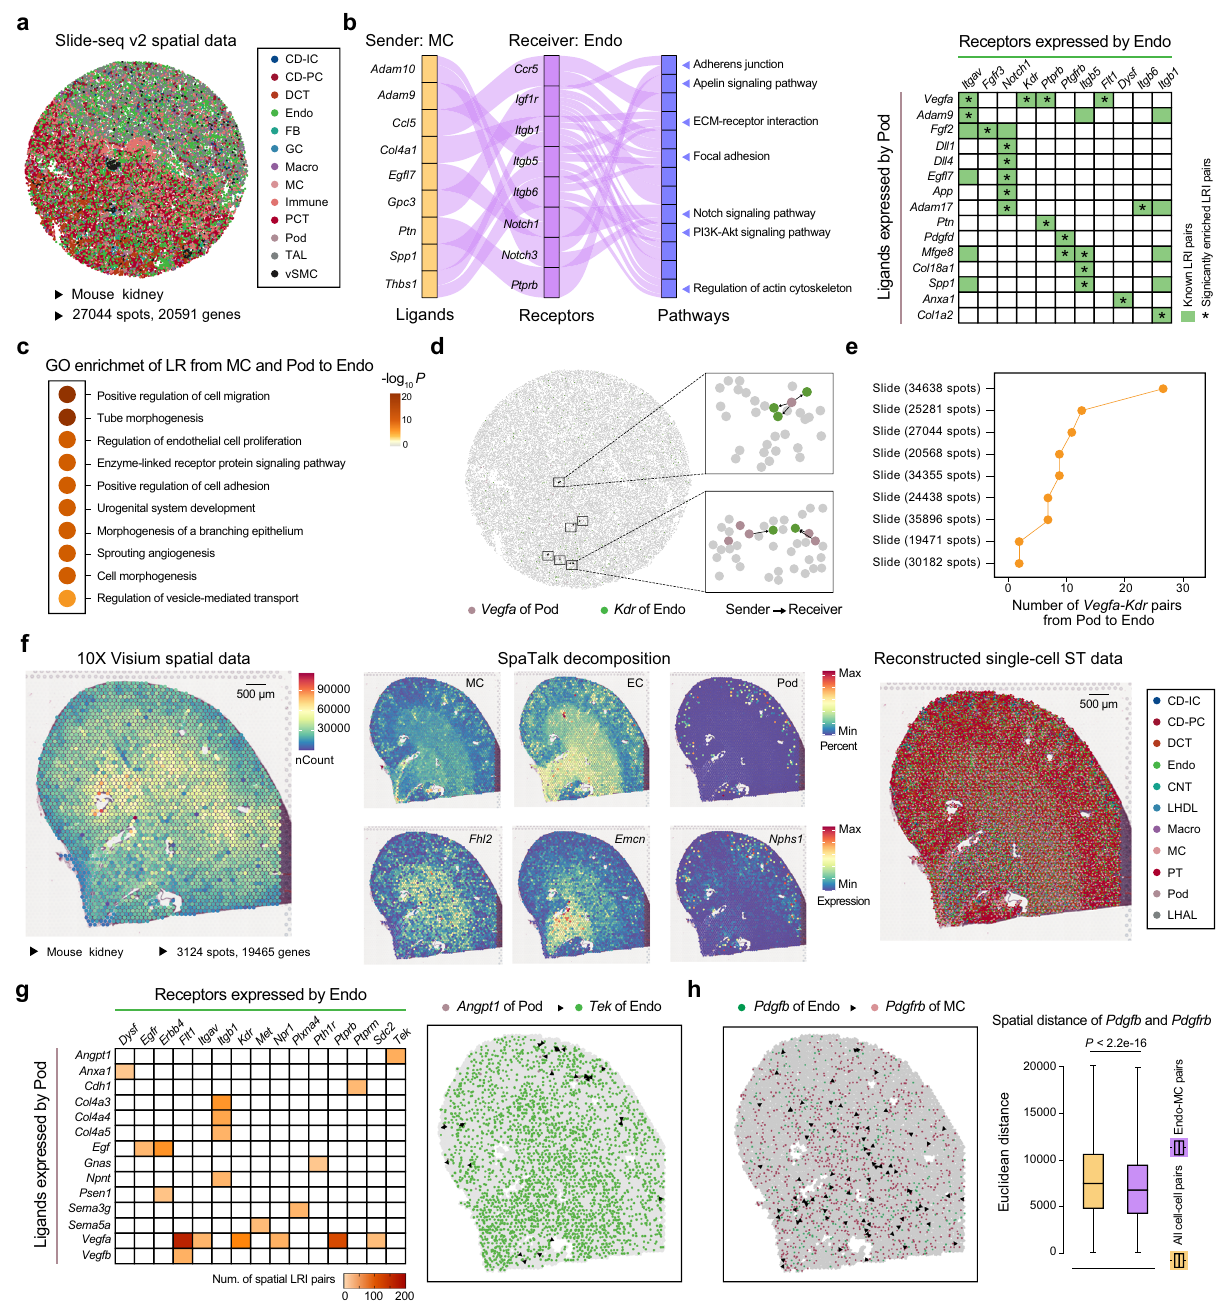
Fig. 4 | Identi fi cation of spatial signal transmission among glomerular cells in kidney. a Slide-seq (v2) ST dataset of the mouse kidney involving 27044 spots and 20591 genes. CD-IC, collecting duct intercalated cells; CD-PC, collecting ductprincipalcells;DCT,distalconvolutedtubules; Endo, endothelialcells;FB, fi broblasts; GC, granular cells; Macro, macrophages; MC, mesangial cells; PCT, proximal convoluted tubules; Pod, podocytes; TAL, thick ascending limb; vSMC, vascular smooth muscle cells. b Signi fi cantly enriched LRIs that mediate cell – cell communications among MC, Endo, and Pod inferred by SpaTalk with P <0.05. The P -value represents the signi fi cance of spatial proximity of LRIs using the permutation test. Top 20 LRI pairs were plotted for Pod-Endo com- munications. c Signi fi cantly enriched Gene ontology (GO) biological processes determinedwiththeMetascapewebtoolfortheligandsandreceptorsfromMC and Pod to Endo inferred by SpaTalk. d Spatial d istribution of the Vegfa-Kdr pairsbetweenthePodsendersand Endoreceivers. e Number of Vegfa-Kdr pairs